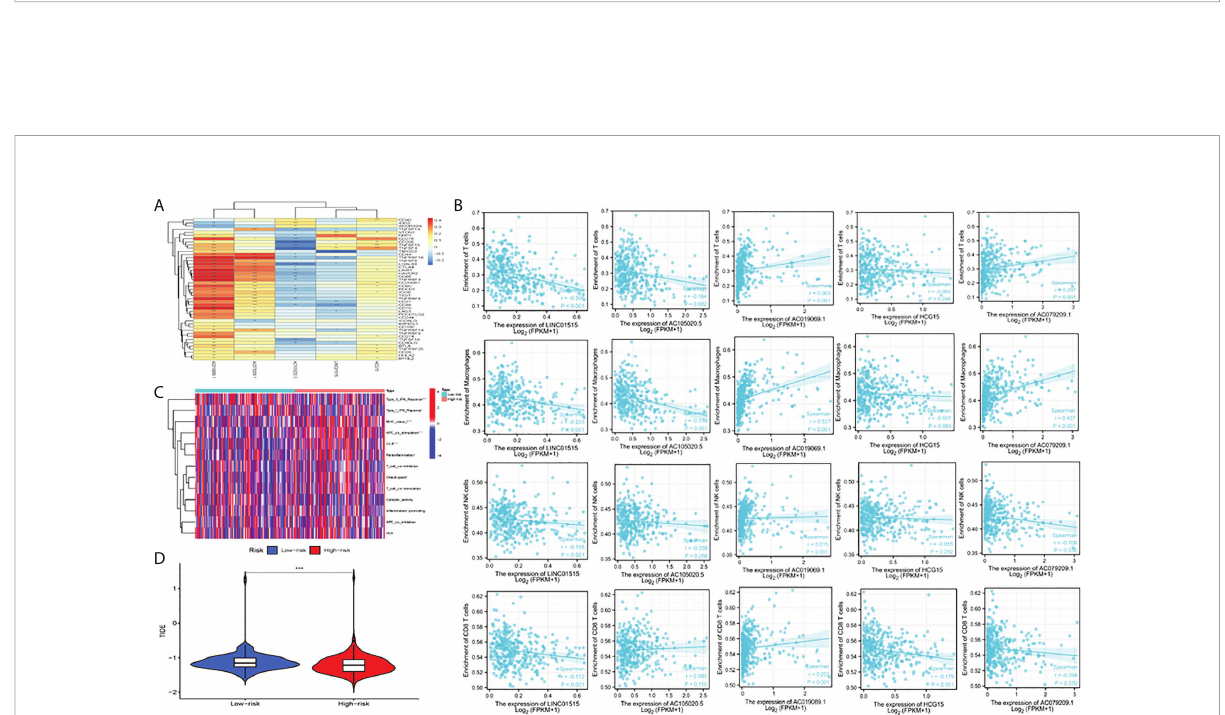
FIGURE 7 Analysis of immune function, escape, and immunotherapy. (A) Correlation analysis between CRLs and the immune checkpoint; (B) Correlation analysis between CRLs and immune cells (T cells, macrophage cells, NK cells and CD8 T cells); (C) Analysis of correlation and difference between high-risk and low-risk groups and immune function; (D) TIDE between high and low-risk groups; TIDE, tumor immune dysfunction and exclusion. *Means P<0.05, **Means P<0.01, ***means